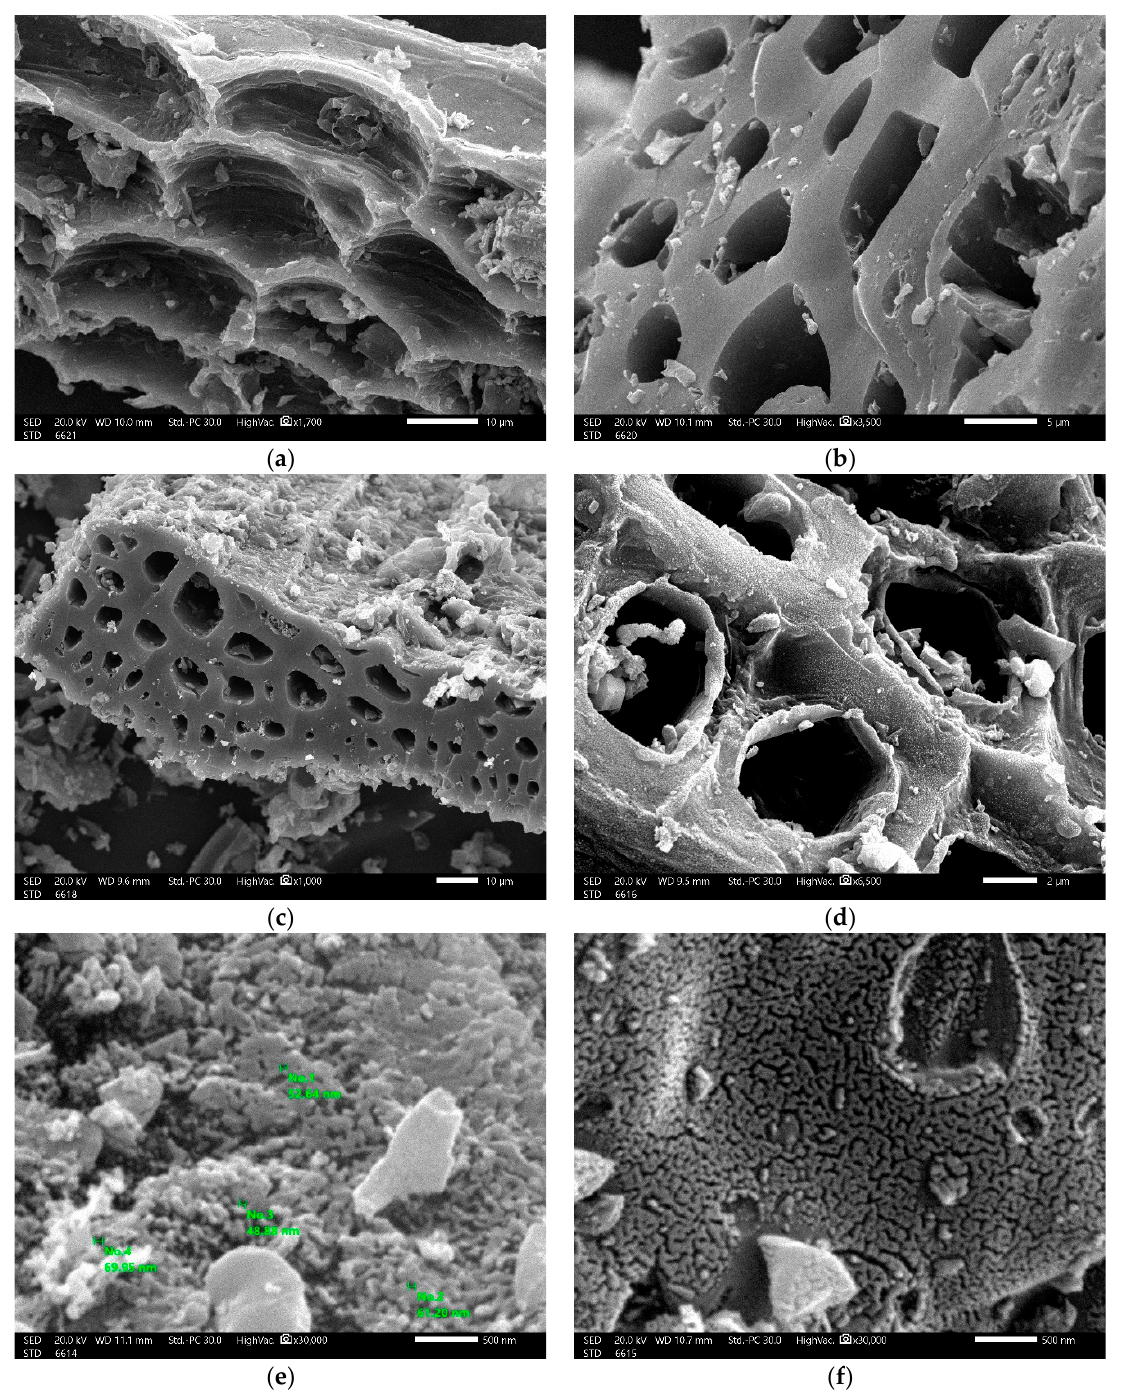
Figure 4. SEM image of pea pods/ZnCl 2 /CO 2 ( a , b ) at 600 °C, ( c , d ) at 700 °C, ( e , f ) at 800 °C (SED 20.0 KV, Std.-PC 30.0 using high vacuum: max. ( a ) (×1700), ( b ) (×3500), ( c ) (×1000), ( d ) (×6500), ( e ), and ( f ) (×30000).